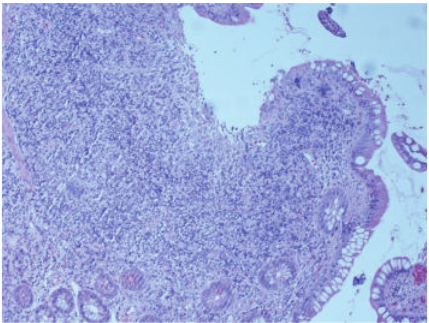
Figure 4: Broad mucosa with displaced glands and mucosal ulcer- ation with mixed inflammatory nongranulomatous cell infiltrate in the lamina